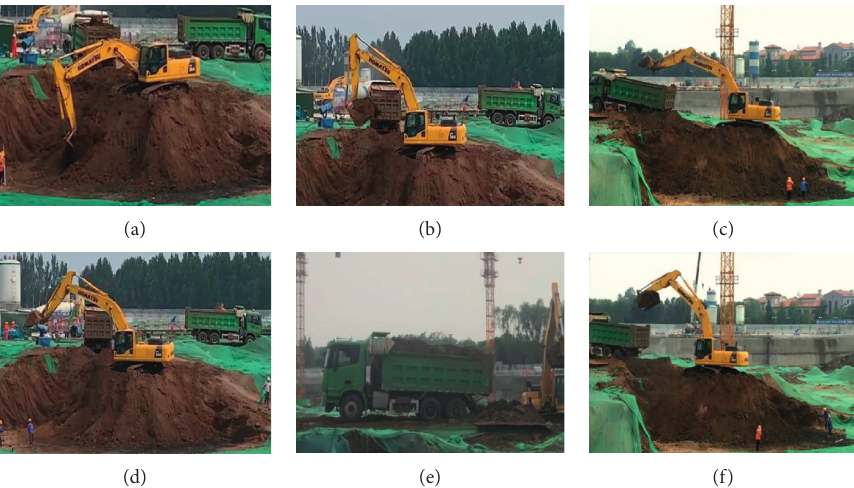
Figure 1: Examples of the activities of an excavator and a dump truck: (a) excavator digging, (b) excavator swinging, (c) excavator dumping, (d) excavator swinging, (e) dump truck moving forward, and (f) dump truck moving backward.